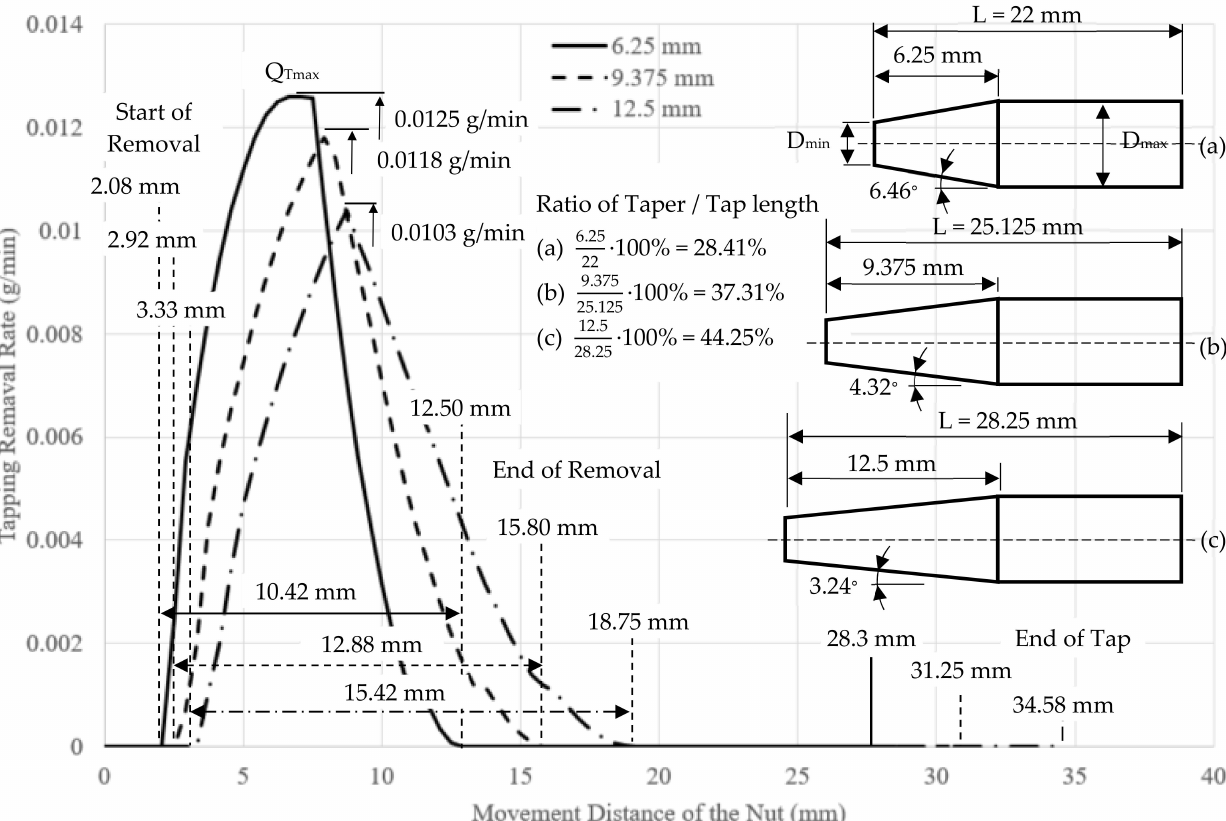
Figure 8. The material removal amount in different taper length: ( a ) 6.25 mm; ( b ) 9.375 mm; ( c ) 12.5